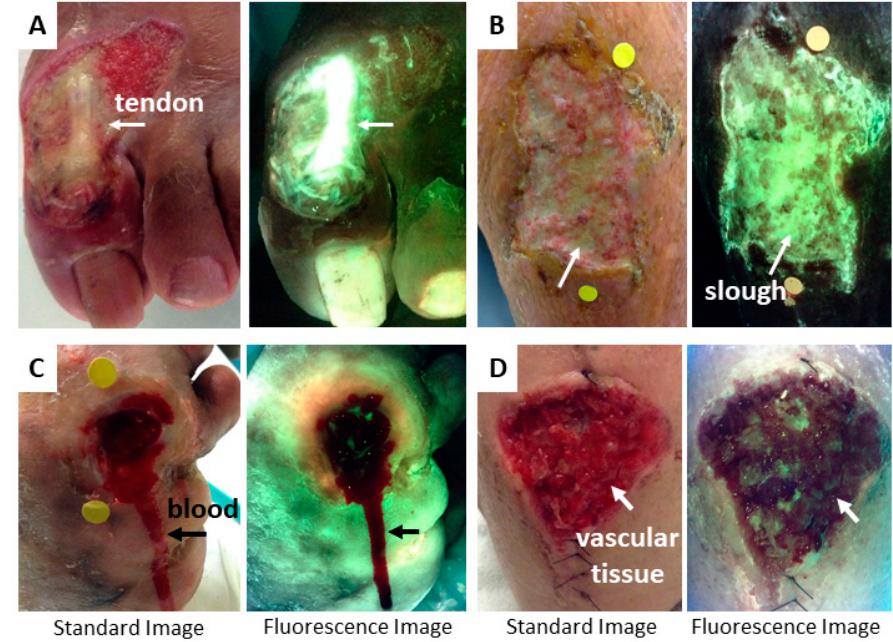
Figure 3. Characteristic fluorescence signals from wound tissues. ( A ) Intense green/glowing white fluorescence from a tendon due to high collagen content. This signal could be confused for P. aeruginosa if the clinician did not compare the fluorescence observed with the standard image of the wound. The standard image makes it obvious that the glowing white region of fluorescence is a tendon. Bright green is also shown in a toenail. ( B ) Slough, which appears yellow on a standard image, fluoresces light green in this venous leg ulcer (VLU) due to high fibrin content. ( C ) Blood from a diabetic foot ulcer (DFU) (post-debridement) appears maroon on fluorescence images due to absorption of the excitation light by hemoglobin. Blood should always be removed from the wound bed prior to imaging. Blush red fluorescence can be seen in the periwound tissue of this DFU, suggesting the presence of bacteria at moderate to heavy loads. ( D ) Highly vascular tissue (e.g., granulation tissue) also fluoresces maroon due to absorption of illumination light by hemoglobin. Note that circular yellow stickers in wounds B and C are for the device’s wound measurement software.